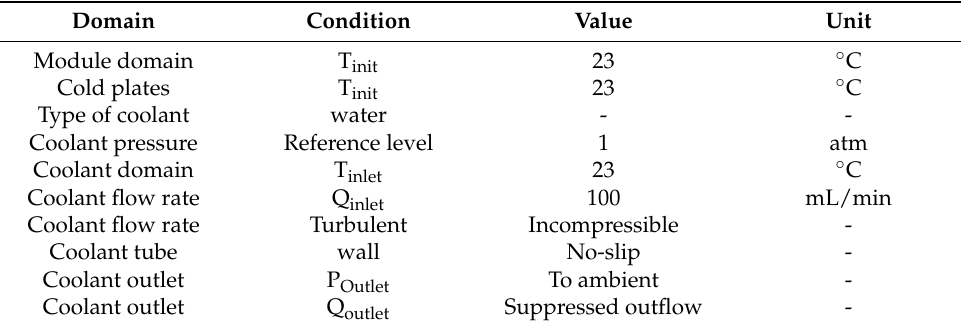
Table 4. Initial conditions and boundaries of the 3D thermal